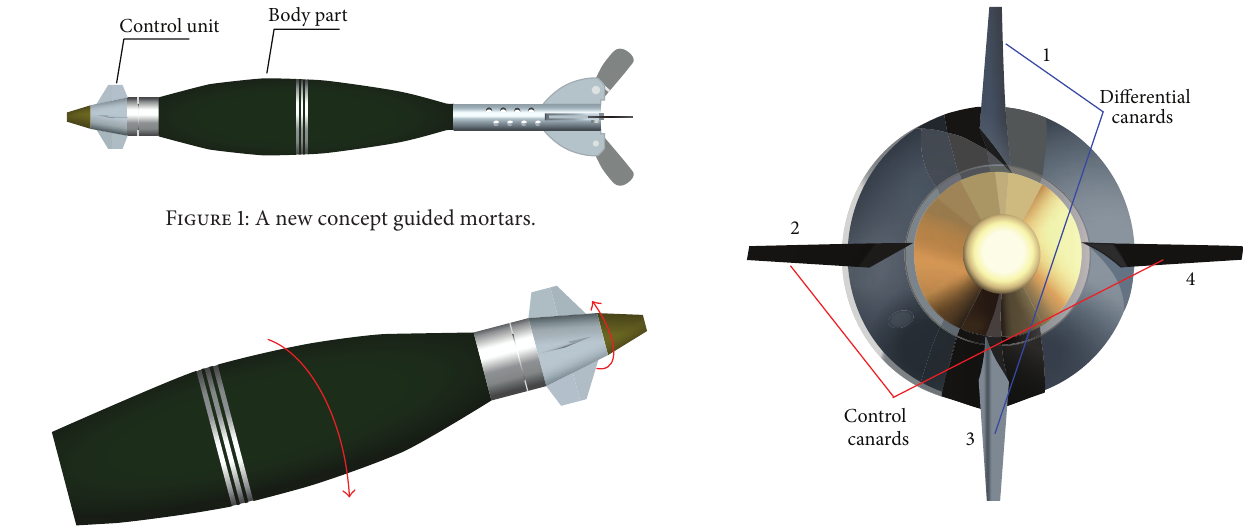
Figure 3: Canards of guidance kit.